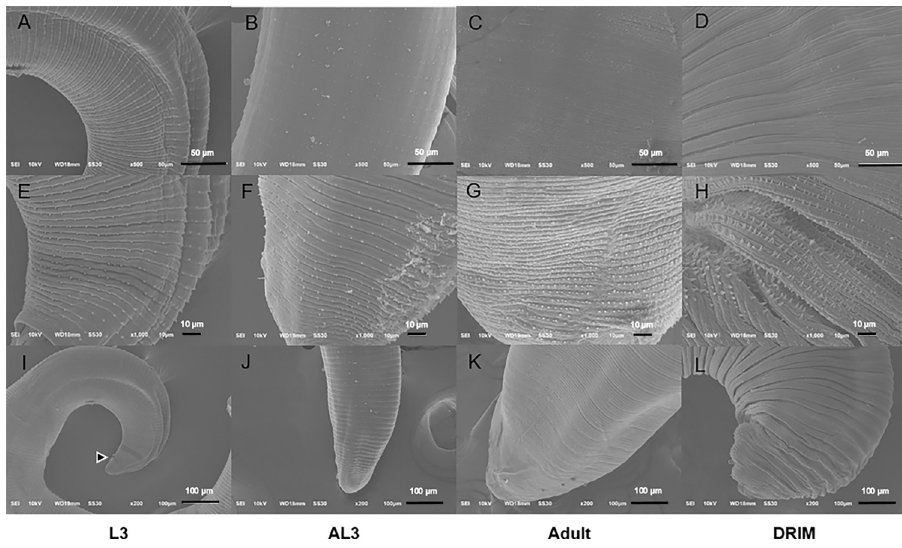
Fig 4. Electron micrographs of the caudal part of G . spinigerum in any stage. Caudal area (A-D); Cuticular spine with higher magnification (E-H); tail (I-L); L3 (A, E, I); AL3 (B, F, J); adult (C, G, K); STIM (D, H, L).